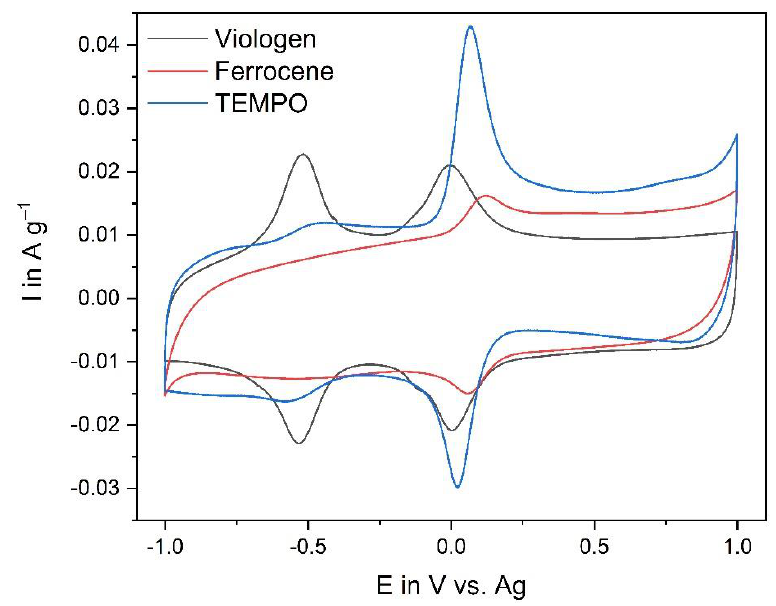
Figure 4. Cyclic voltammograms of 0.1 M RAILs in Pyr 14 TFSI at 0.1 mV s − 1 in half-cell setup with an AC working electrode.